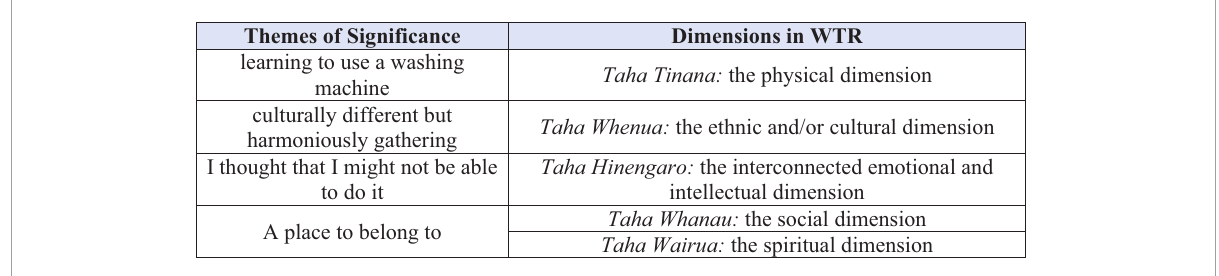
FIGURE2 Correspondance between the theoretical dimensions and major empirical themes.